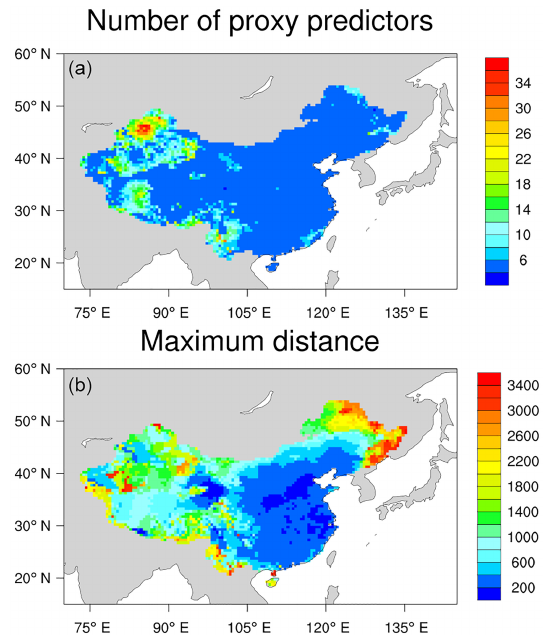
Figure 2. The spatial distributions of the number of proxy predic- tors (a) and the maximum distance from the predictor to the tar- get (b) for each grid